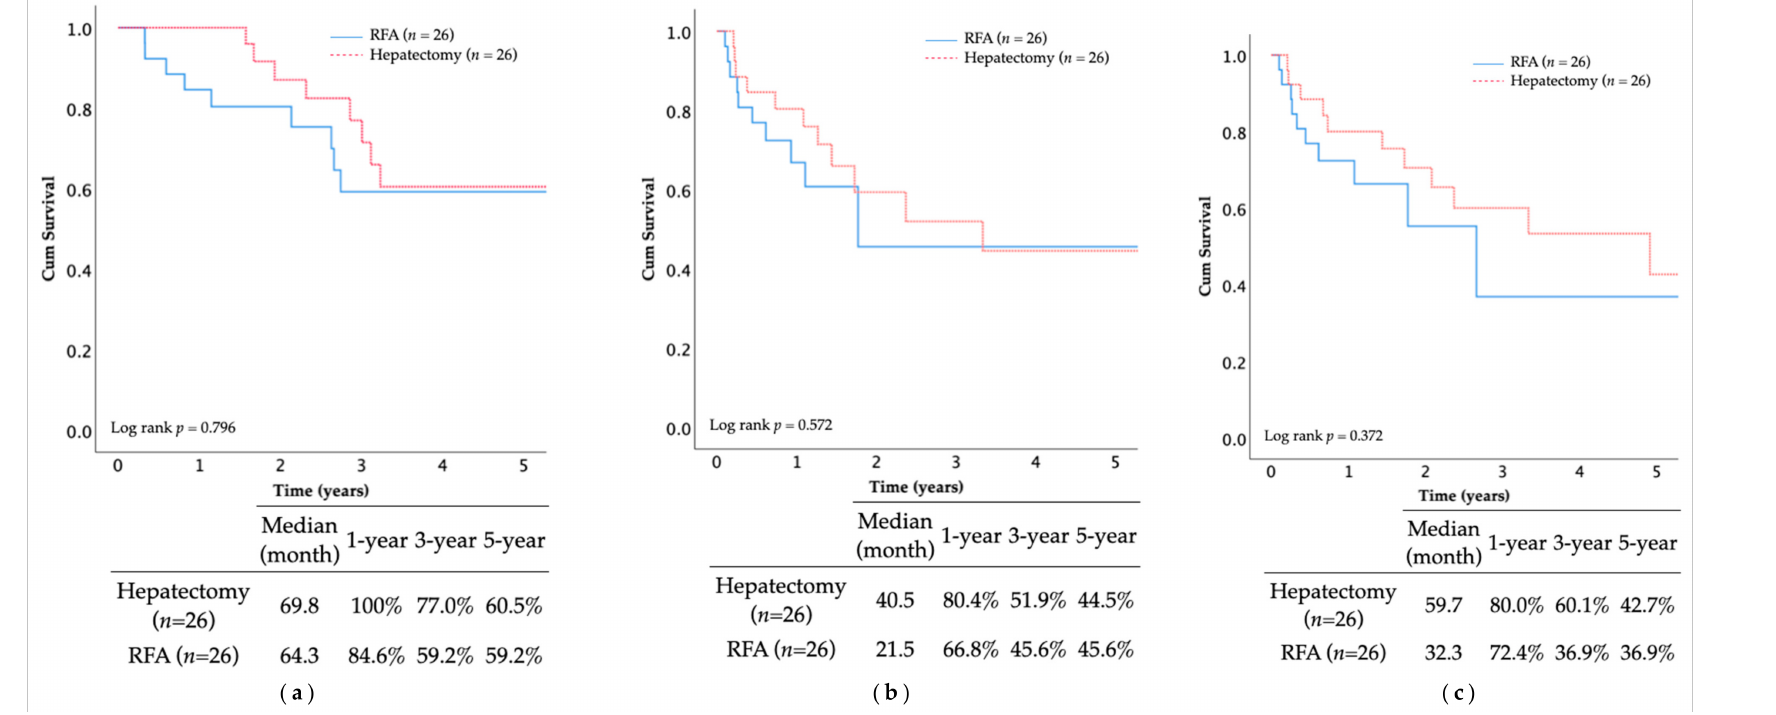
Figure 5. The OS rate ( a ), RFS rate ( b ), and IHRFS rate ( c ) of the multi-RFA and hepatectomy groups were still comparable after